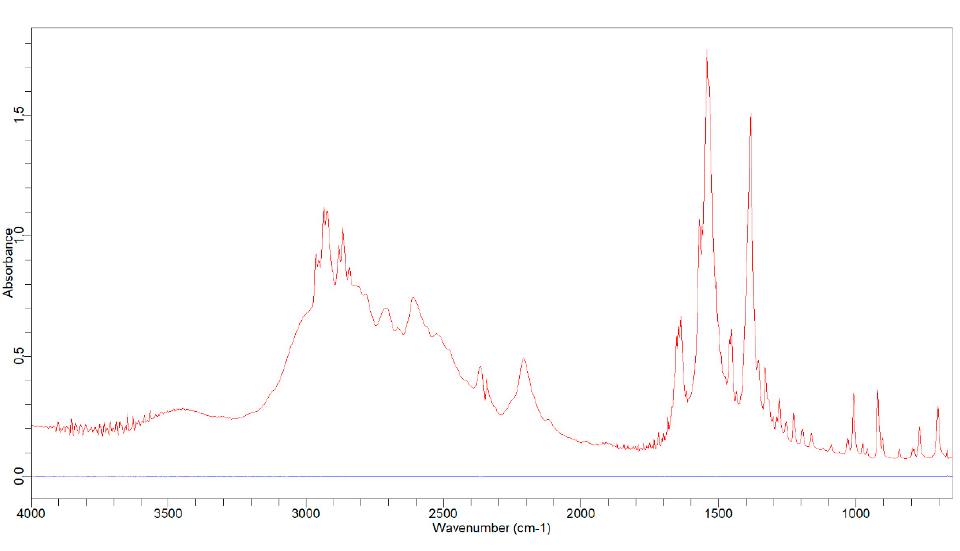
Figure 2. Overlay spectrum of potassium bromide (blue line) and tranexamic acid (red line). Table 2. Specific wavenumbers and functional groups of tranexamic acid.